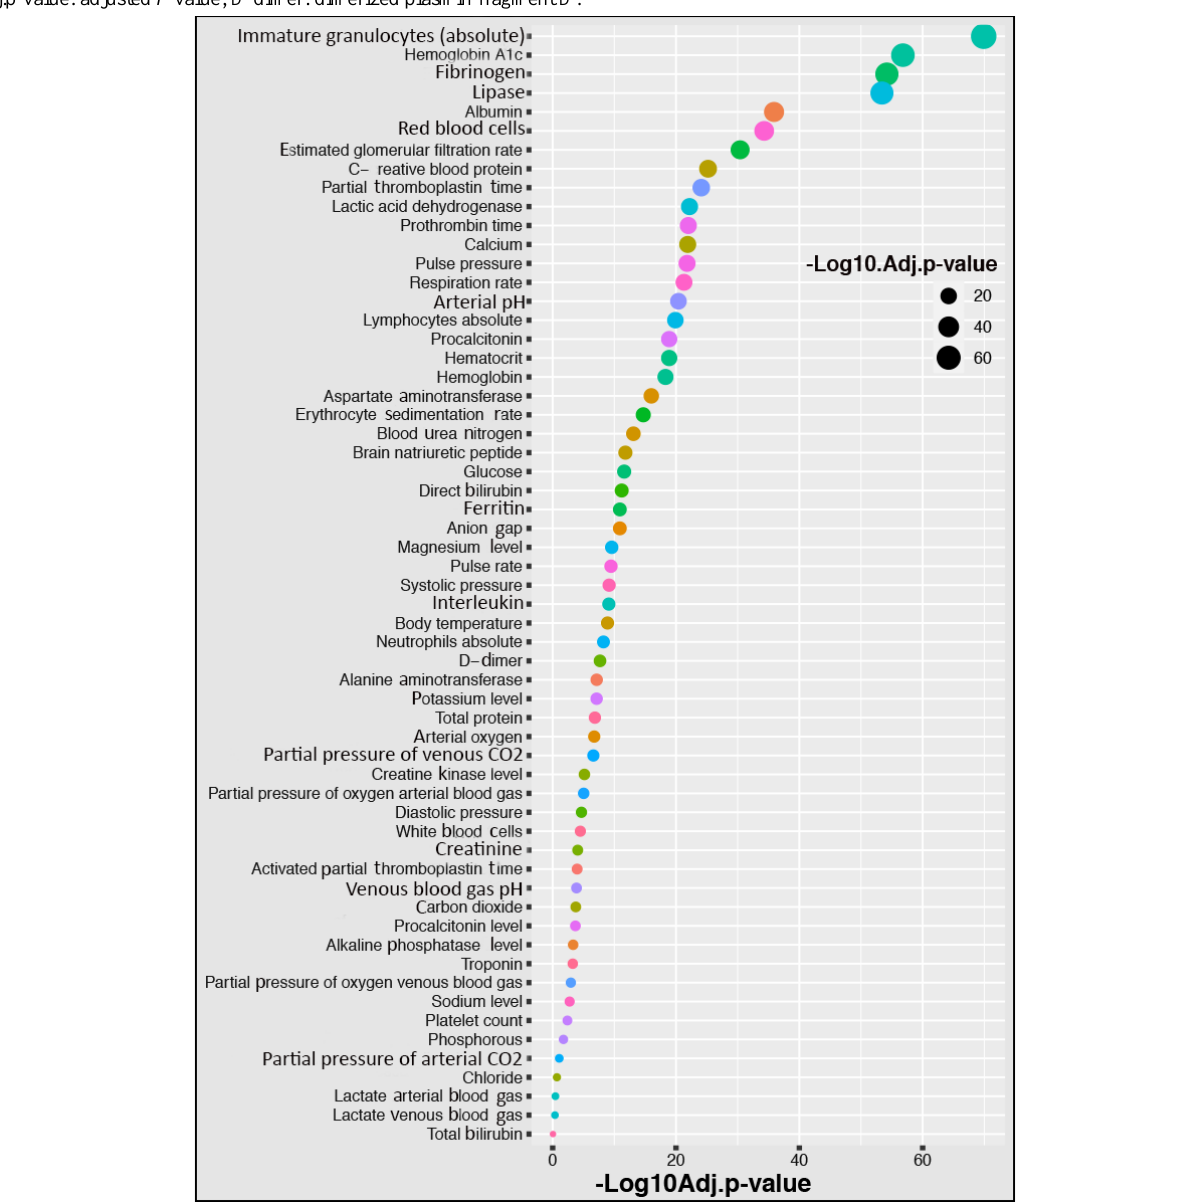
Figure 3. Parameter measurements for various blood parameters and significant differences (using t tests) between patients with and without COVID-19. Adj.p-value: adjusted P value; D-dimer: dimerized plasmin fragment